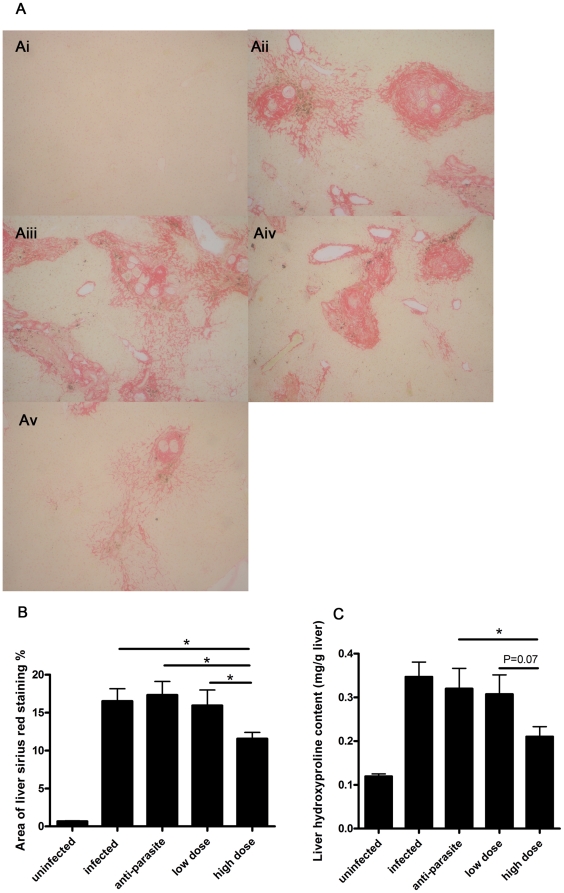
Anti-fibrosis treatment with prizaquantel reduced areas of liver Sirius Red staining and liver hydroxyproline content in mice 15 weeks post infection with Schistosoma japonicum.(A) Representative images of Sirius Red staining by light microscope (×100). Ai, uninfected; Aii, infected; Aiii, anti-parasite; Aiv, low dose; Av, high dose. (B) Statistical analysis of scanned images in Sirius Red staining by software IPP6.0. (C) Measurement of Liver hydroxyproline content. (* p<0.05).